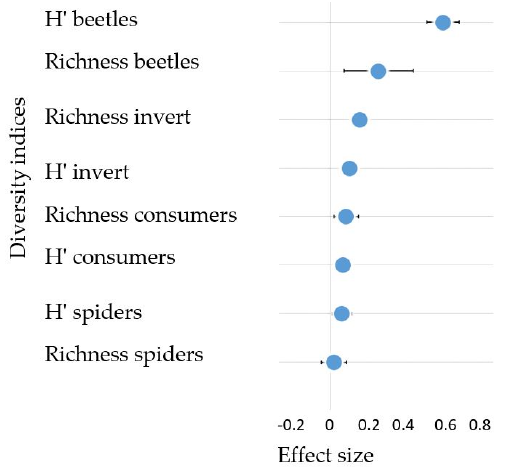
Figure 6. Mean effect size (log response ratios ± 95% CI) showing the change between forested buffered sites situated downstream and upstream sites without forested riparian buffers for diversity indices that characterize the riparian invertebrate community (Richness = taxa richness, H (cid:48) = Shannon diversity index, Consumers = Araneae, Carabidae and Staphylinidae, beetles = Carabidae and Staphylinidae, spiders = Araneae, invert = all 39 identified invertebrate